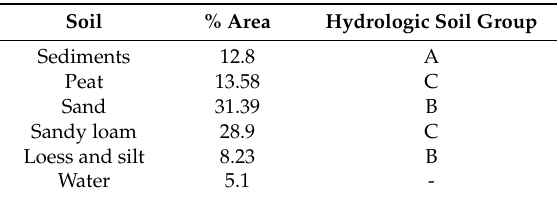
Table 1. Information used for the selection of CN values.